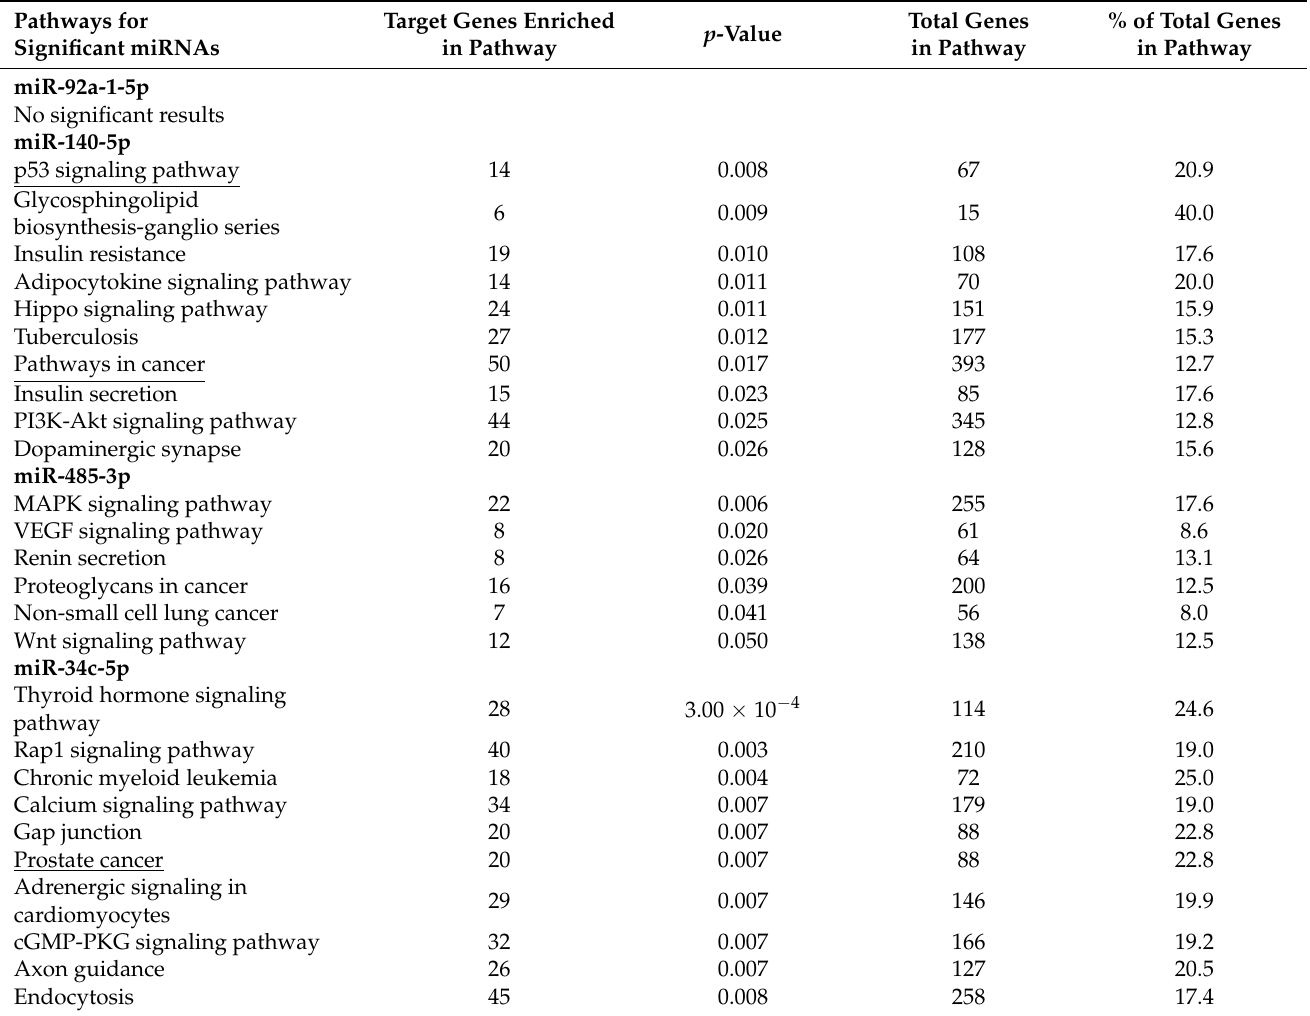
Table 4. Pathway analyses of the miRNAs with significant results. Analysis was conducted with the genes predicted by at least two target prediction programs. A maximum of ten of the most significantly enriched pathways for each studied miRNA, with nominal p -value < 0.05 are shown. MiR-550a-3p was excluded from the analysis, since it had no gene targets predicted by at least two prediction